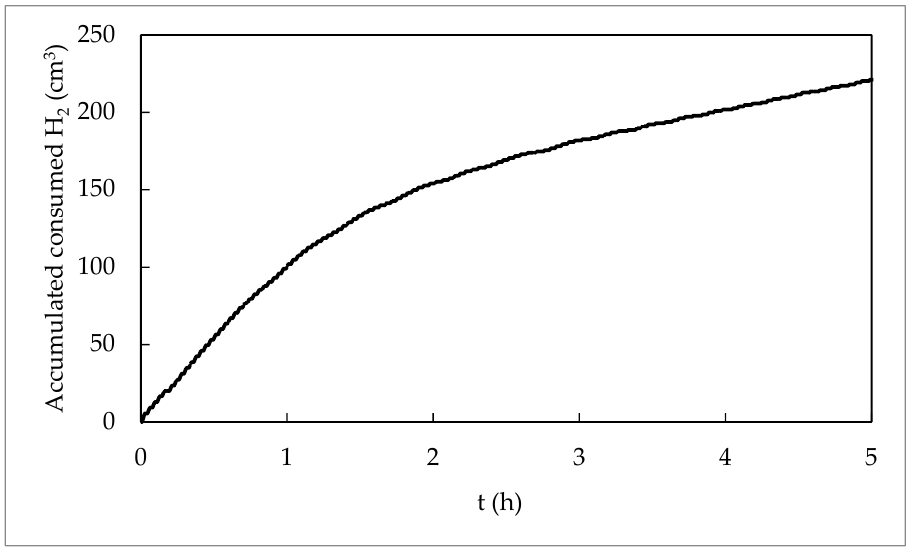
Figure 2. H 2 consumption versus time during CH hydrogenation in toluene with catalyst SA20-RhCOD (5% vol CH in toluene, 333 K, 10 bar H 2 ).